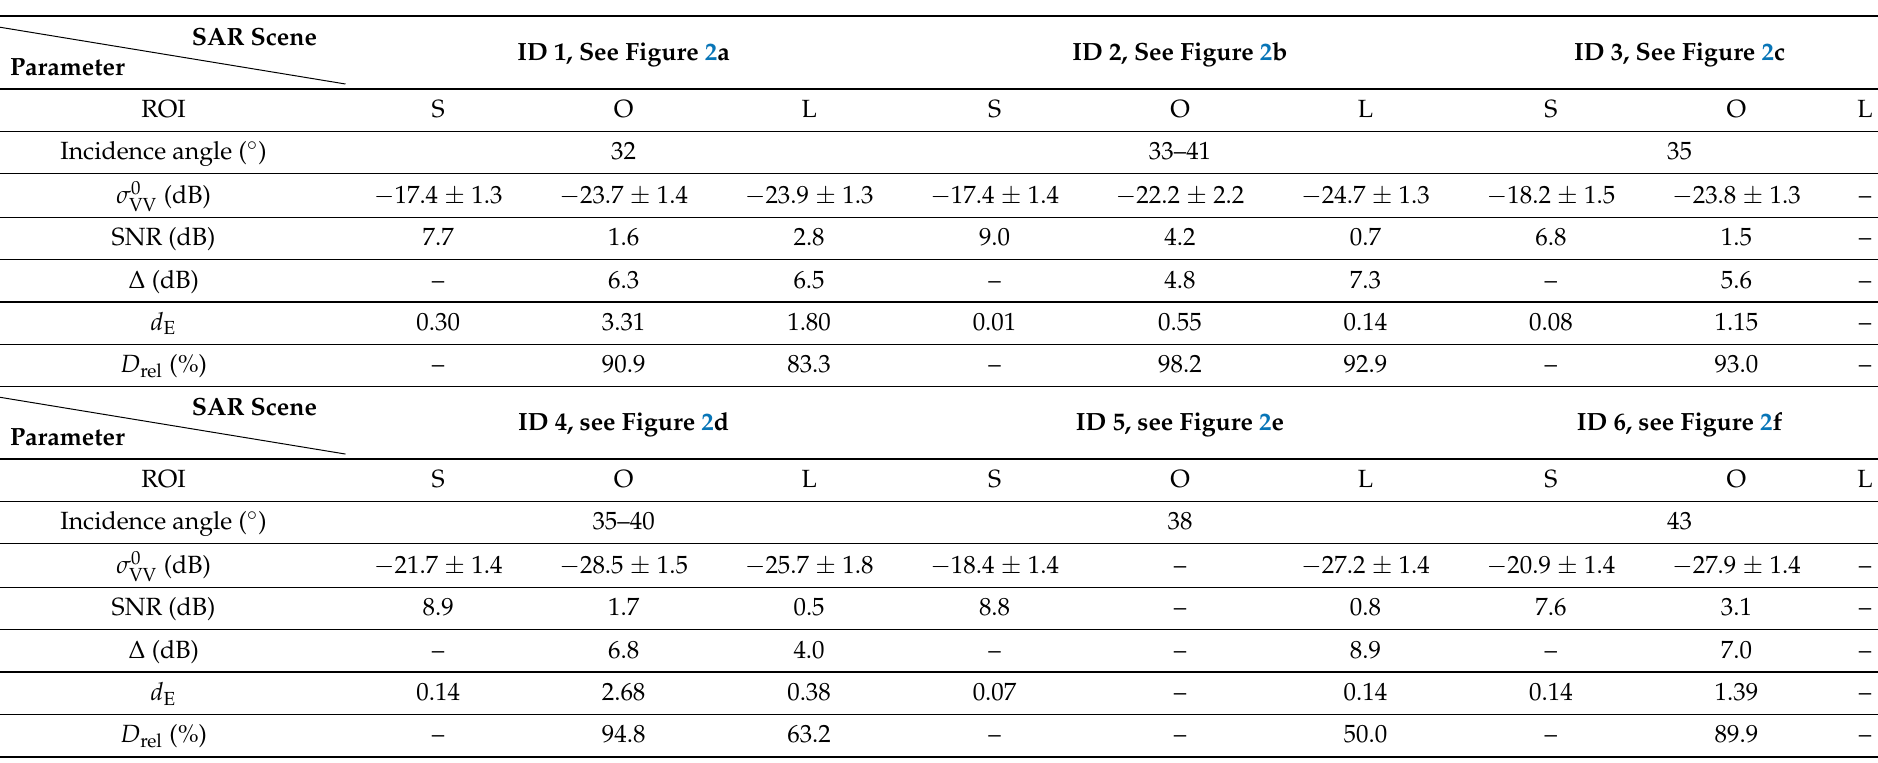
Table 2. Experimental results relevant to the ROIs selected from the SAR dataset shown in Figure